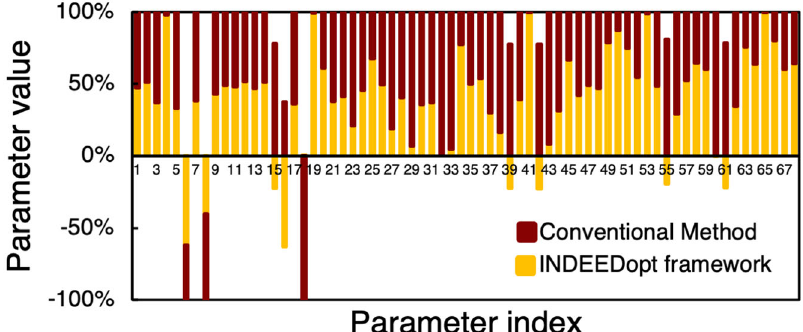
Fig. 9 The comparison of W – S – C – O – H force fi eld parameters optimized by different methods. The stacked bar graph representation of the difference between the parameter values in the tungsten – sul fi de – carbon – hydrogen training set optimized using INDEEDopt with brute force and conventional method. The red represents the conventional and yellow represents INDEEDopt version of the same parameter. The difference between the percentage values corresponds to the difference between predicted values by each method. The value 50% corresponds to a situation when both methods predict the same values. If the predicted parameter values are negative, then the percentage value is given as negative.